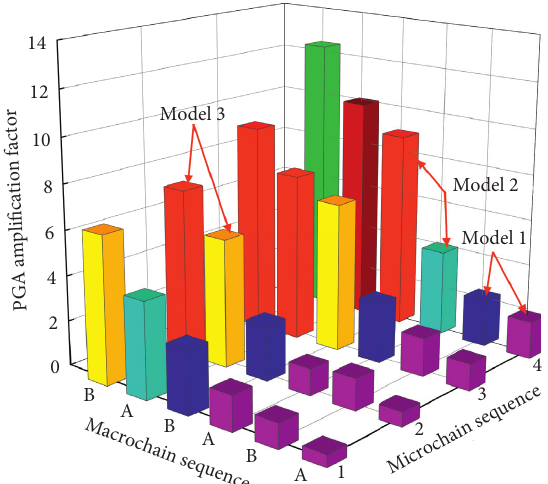
Figure 10: Distribution of PGA amplification coefficient of rock